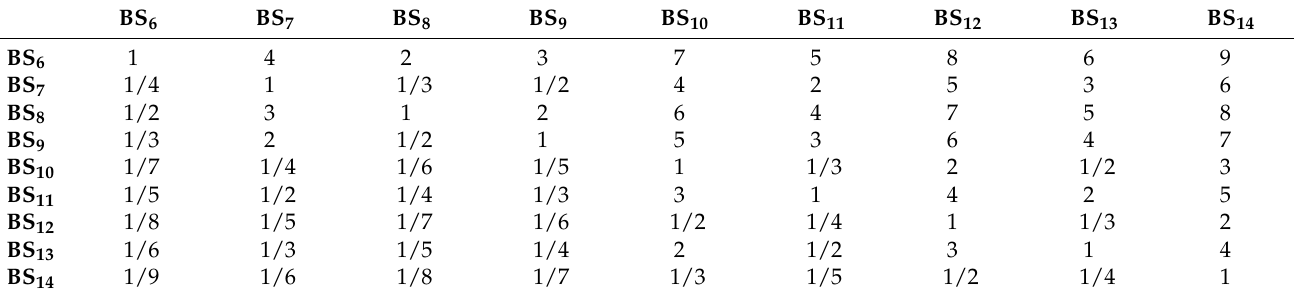
Table A17. The pairwise comparison matrix Admin _ C 5 .